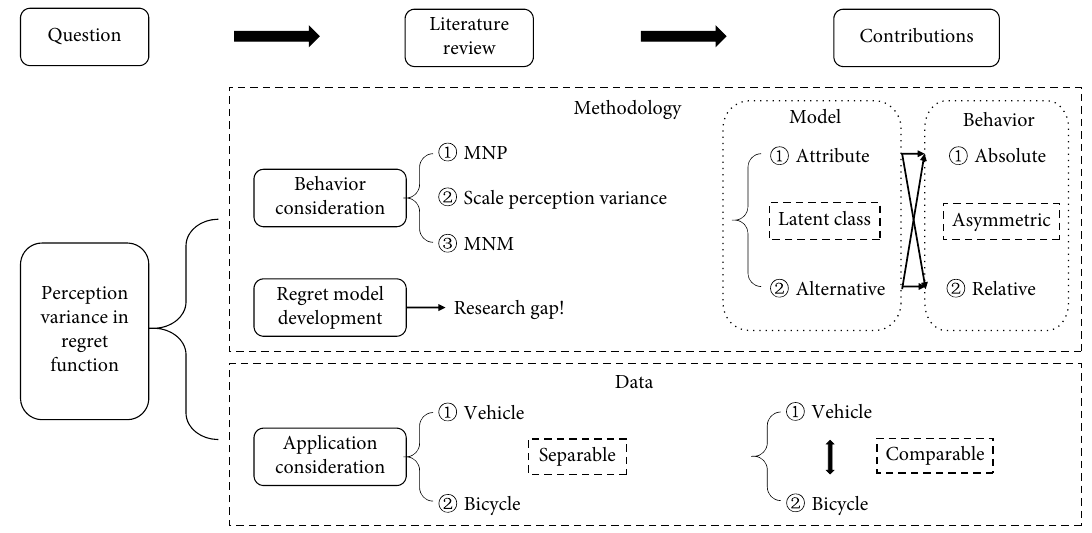
Figure 1: Ideas and basic structure of this